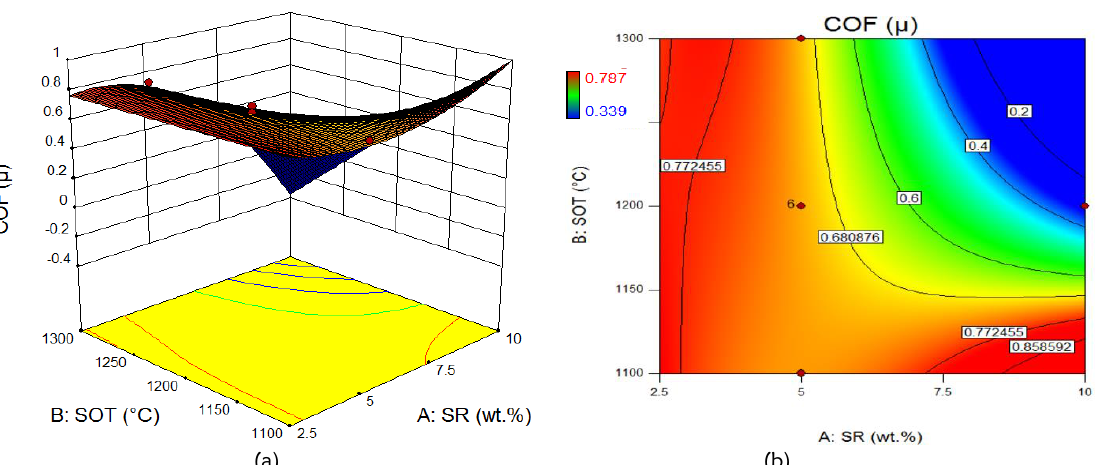
Figure 8: (a) 3-D surface plot, and (b) 2-D contour plot showing the variation of coefficient of friction with silicon carbide weight and surface oxidation